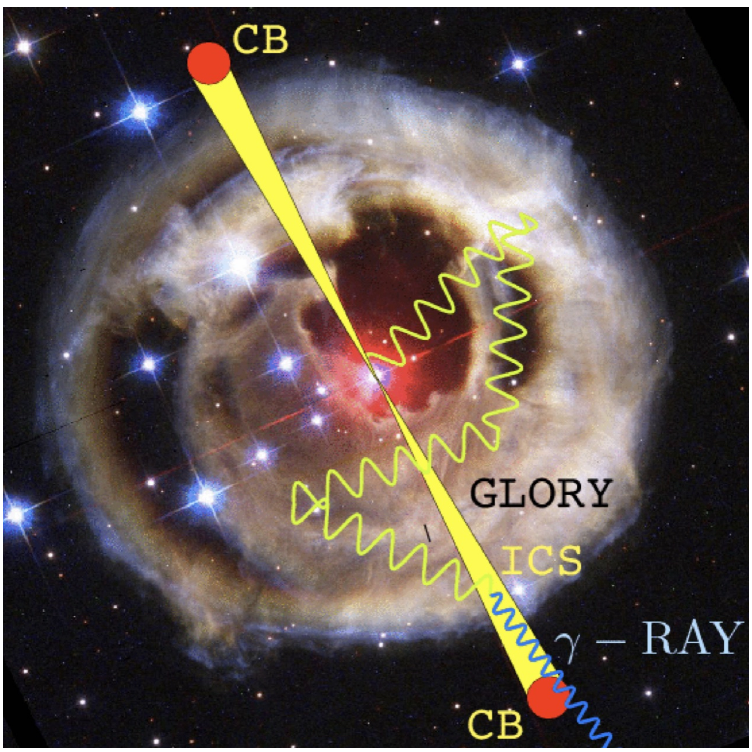
Figure 1. Electrons in a cannonball inverse Compton scatter photons in the glory of light surrounding a newly-born compact object, launching them forward as a narrow beam of γ